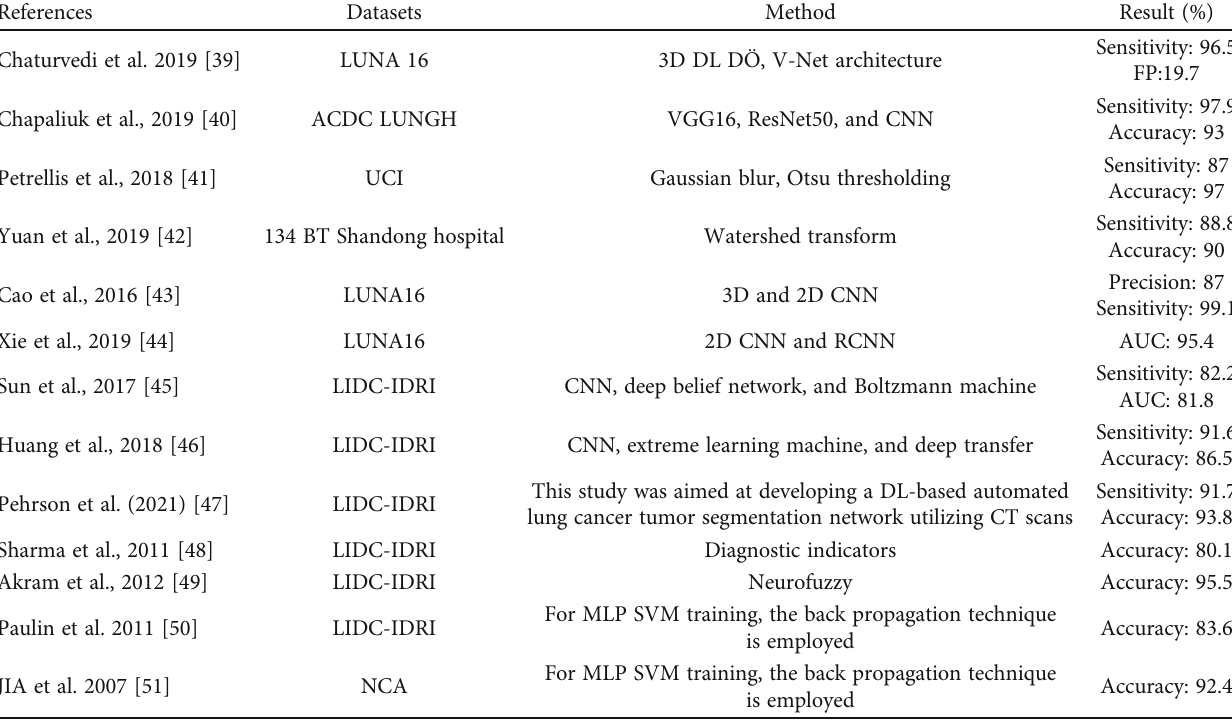
Table 2: Comparison to the literature works.